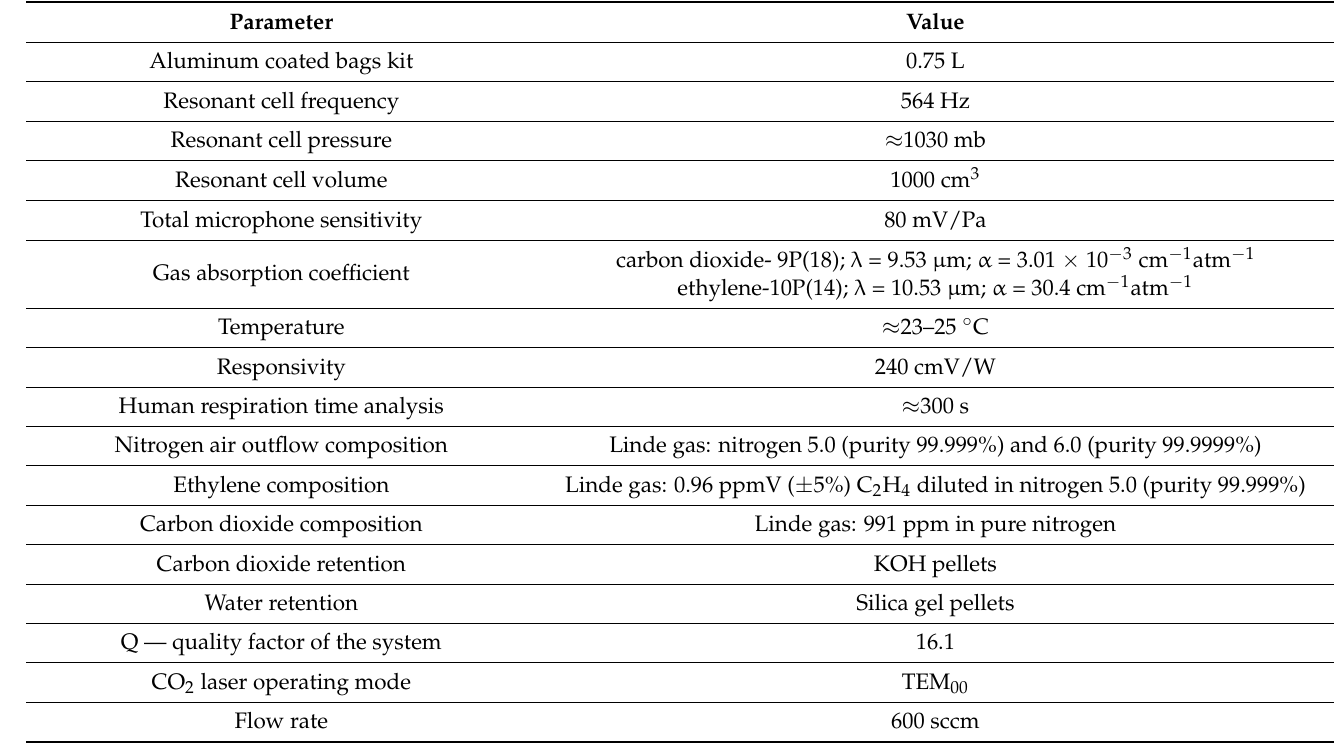
Table 1. Measurable factors for gases detection in human respiration after wearing surgical face